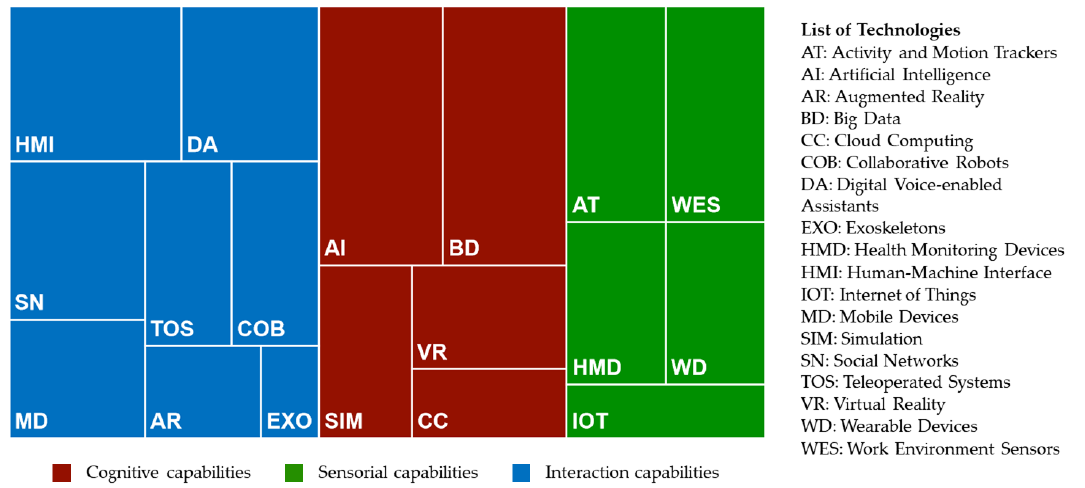
Figure 6. Treemap chart of the perception of the most ethically problematic technologies in industry. 407